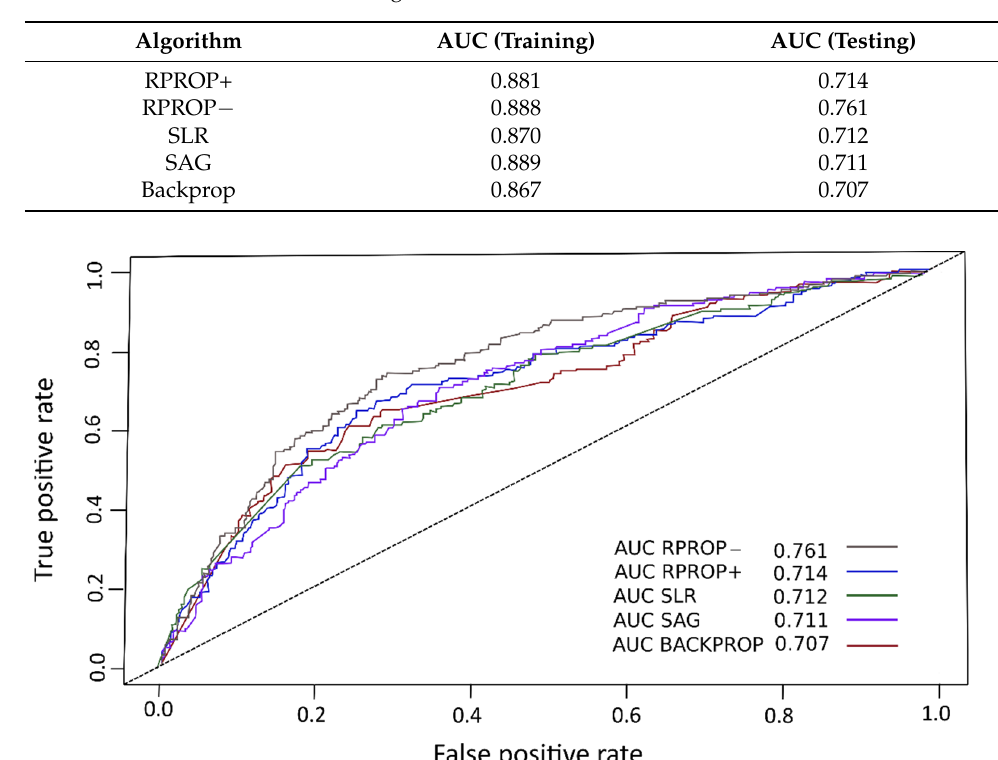
Figure 7. ROC curves of ANN algorithms implemented.